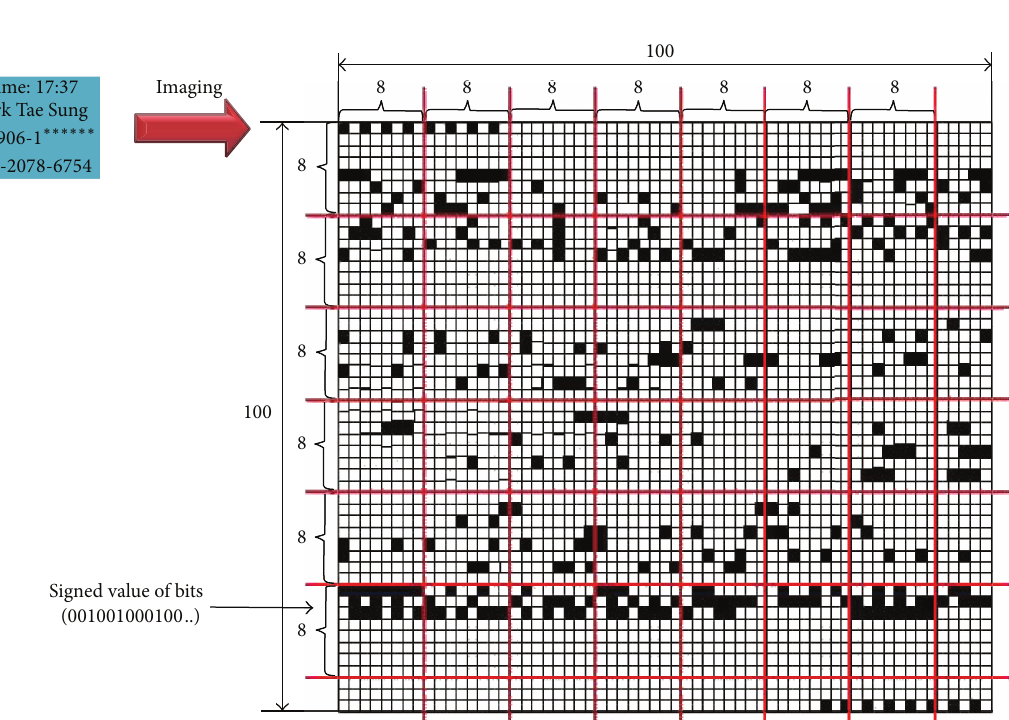
Figure 5: Before shift of steganography-inserted